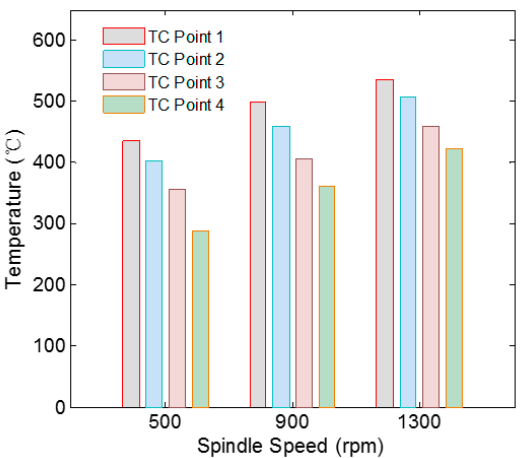
Figure 7. Temperature distribution at different spindle speeds.